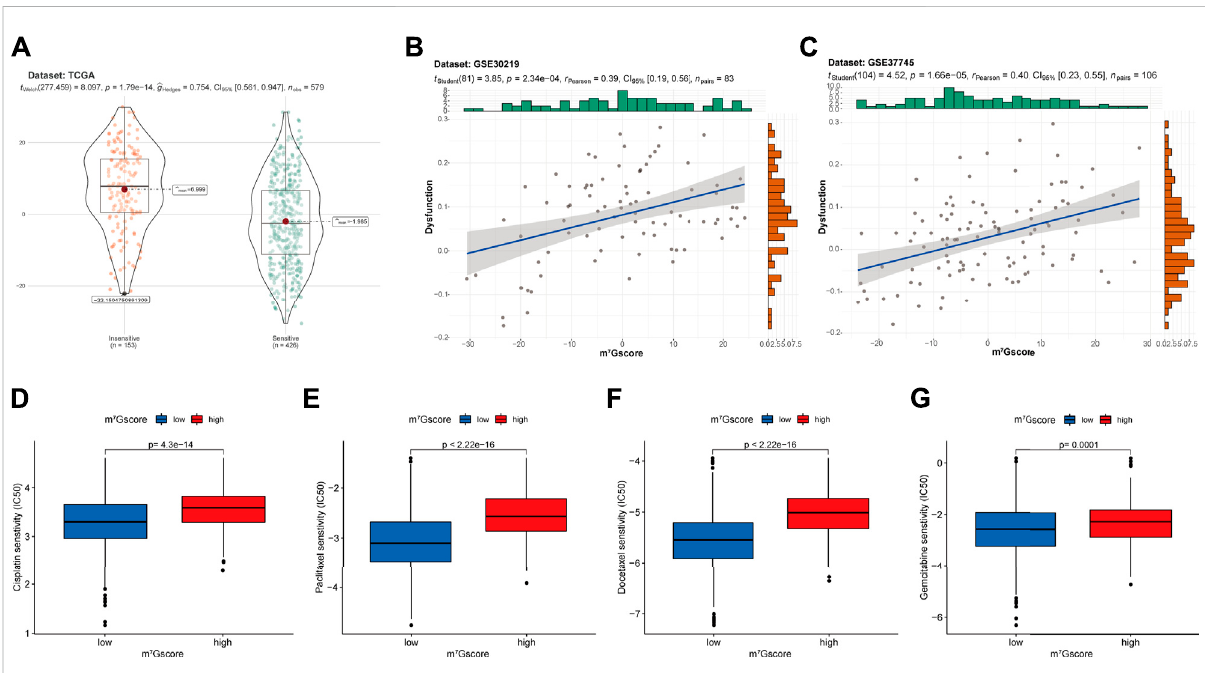
FIGURE 8 The correlation of m 7 Gscore and the therapeuticresponse. (A) The difference in m 7 Gscore between sensitive and insensitive groups divided by TIDE algorithm in TCGA-LUAD cohort. (B,C) The correlation of m 7 Gscore and the T cell dysfunction signature in GSE30219 (B) and GSE37745